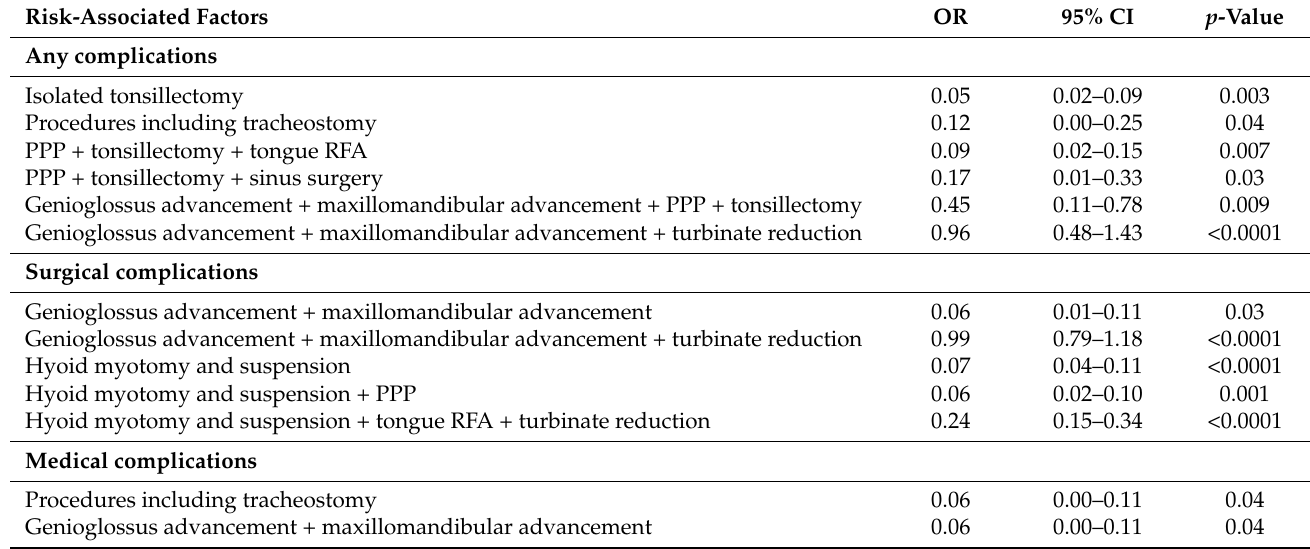
Table 8. Multivariable assessment of any, surgical, and medical complication occurrences with regard to different types of